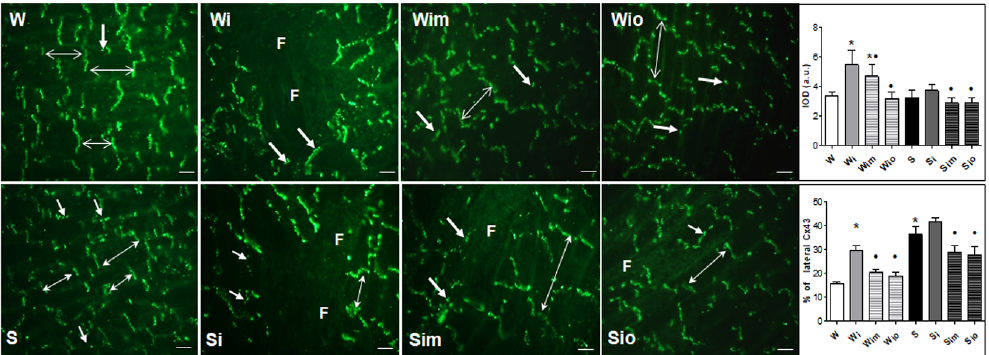
Figure 5. The myocardial topology of Cx43 immunofluorescence labeling. Note absence of Cx43 in areas of injury (F) and disordered distribution of Cx43 in surrounding viable cardiomyocytes in ISO-exposed heart (Wi, Si) compared to controls (W) with a regular polar distribution of Cx43 confined to intercalated discs (long arrows) and lateral sides of the cardiomyocytes (short arrows) that is more frequent in Spontaneously hypertensive rat (S) hearts. Abnormal distribution of Cx43 was attenuated by treatment with melatonin (Wim, Sim) and omega-3 (Wio, Sio). Quantitative image analysis revealed enhanced Cx43 positive signals in ISO-exposed rats that were suppressed by treatment (upper graphs). Importantly, the treatment of ISO exposed rats by melatonin and omega-3 significantly suppressed laterally distributed Cx43 (bottom graphs). * p < 0.05 compared with W; • p < 0.05 compared to Wi vs. Wim, Wio/Si vs. Sim, Sio. Bar 100 um.